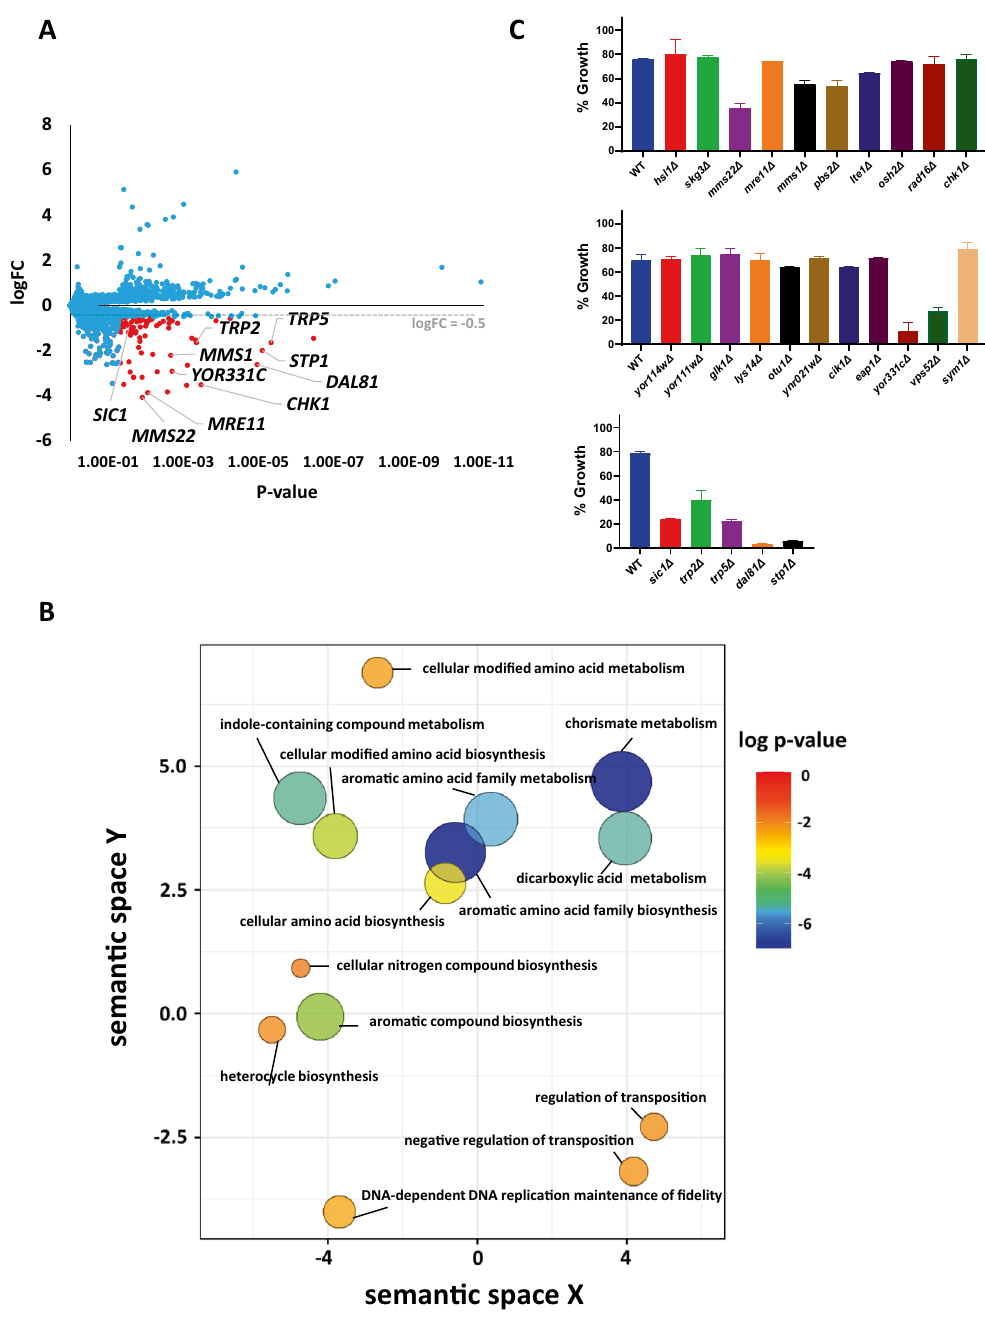
Figure 3. Chemogenomic profiling of DEP. ( A ) Plot of logarithm of fitness coefficient (logFC) versus P -value derived from homozygous profiling (HOP) assay of DEP. Mutants with logFC < − 0.5 and P -value < 0.05 are displayed as red dots while the rest are displayed as blue dots. Only gene names of the tested mutants deemed significant are annotated in the plot for visualization. The grey dotted line represents logFC of − 0.5. ( B ) Gene ontology (biological process) enrichment analysis of DEP with REVIGO. GO terms obtained from web-based tool DAVID are filtered out by the REVIGO server for redundancy. GO terms which share semantic similarities are clustered together in the 2-dimensional scatterplot. P-value (for the enrichment strength in the annotation category) is depicted by the bubble colour while GO term frequency is depicted by bubble size. ( C ) Validation of HOP data of DEP. Wild type and various deletion mutants were exposed to a series of DEP concentrations in duplicate overnight. Growth measurements (OD 600 ) were normalized and plotted for each deletion strain at 1.56 mM DEP. Representative data from one of three biological replicates is shown. Error bars indicate standard deviation ( N =